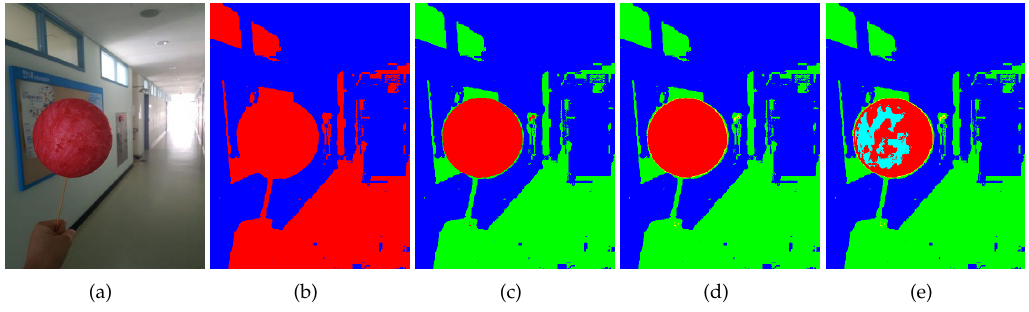
( 1 ) S ( 1 ) differently m and d ( 2 ) ( 2 ) S ( 1 ) , and S colored in m , d d